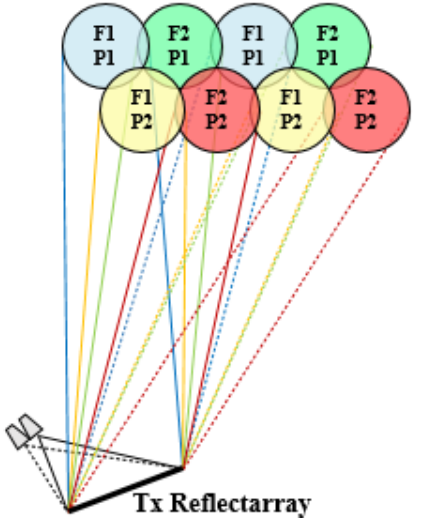
Figure 4. Operating principle of the proposed single-band reflectarray.